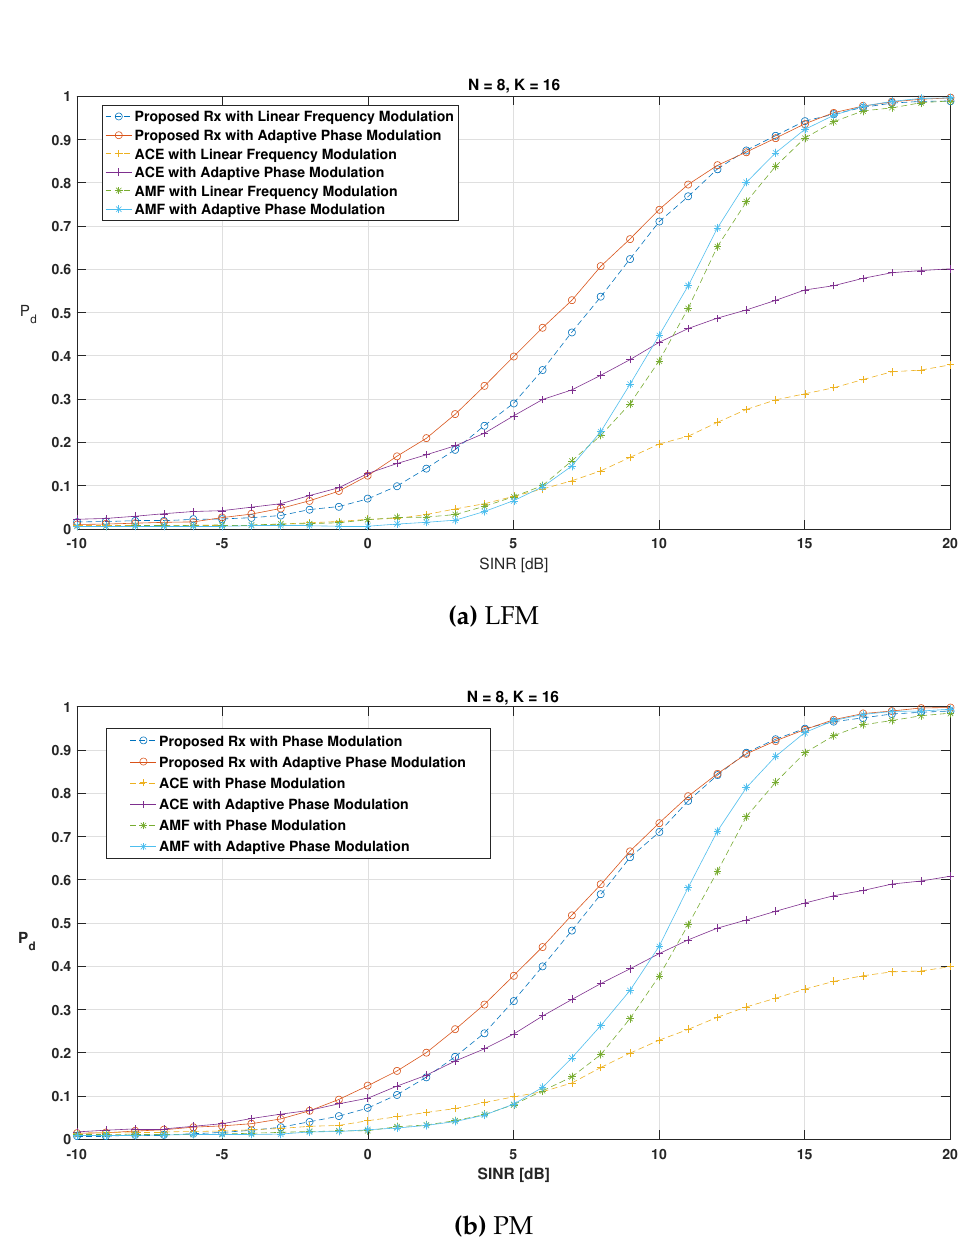
Figure 6. P d versus SINR curves using N = 16 LFM pulses, and N = 8 LFM chirps followed by N = 8 adaptive phase modulated (APM) waveforms; P fa = 10 − 2 , L = 30.